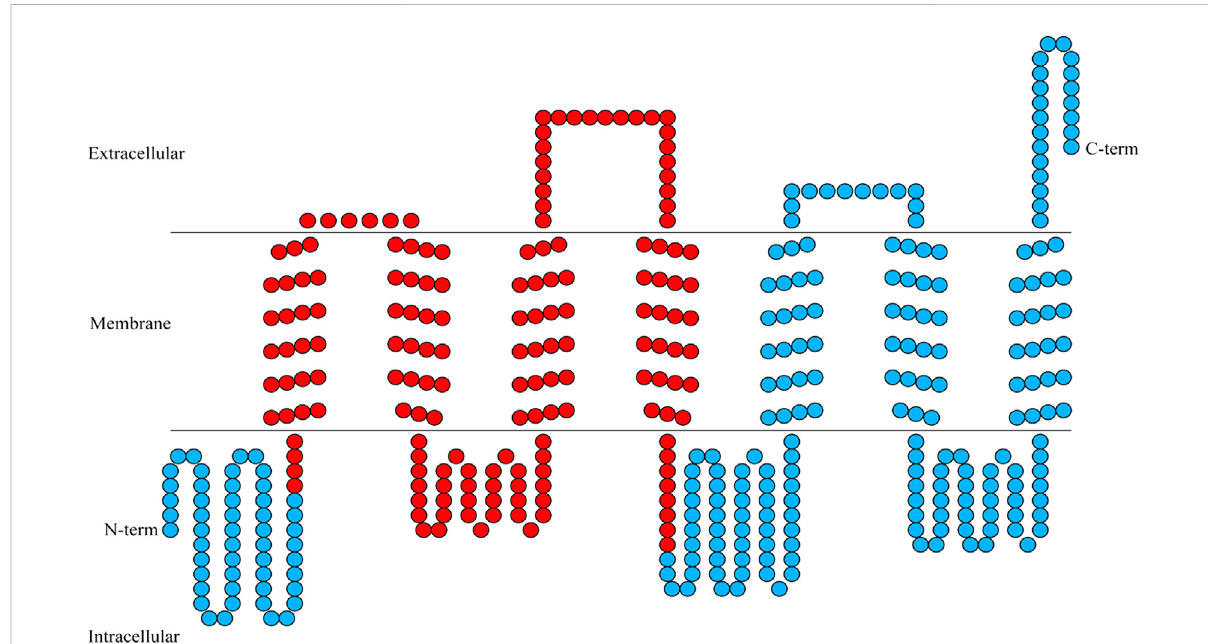
FIGURE 1 Transmembrane helical structures in the amino acid sequence encoding BtGR11. Each circle represents an amino acid, and the red circles represent the region of